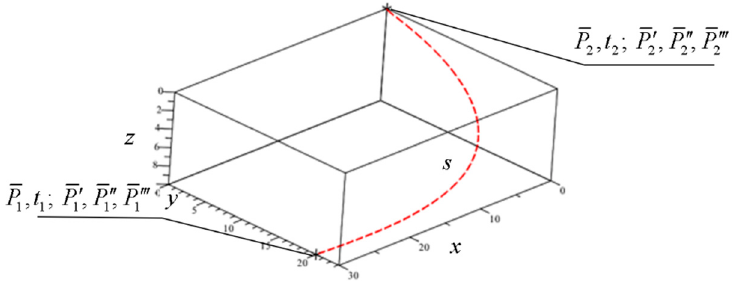
Figure 12. Initial conditions for construction of a seventh-degree Hermite spline curve segment.